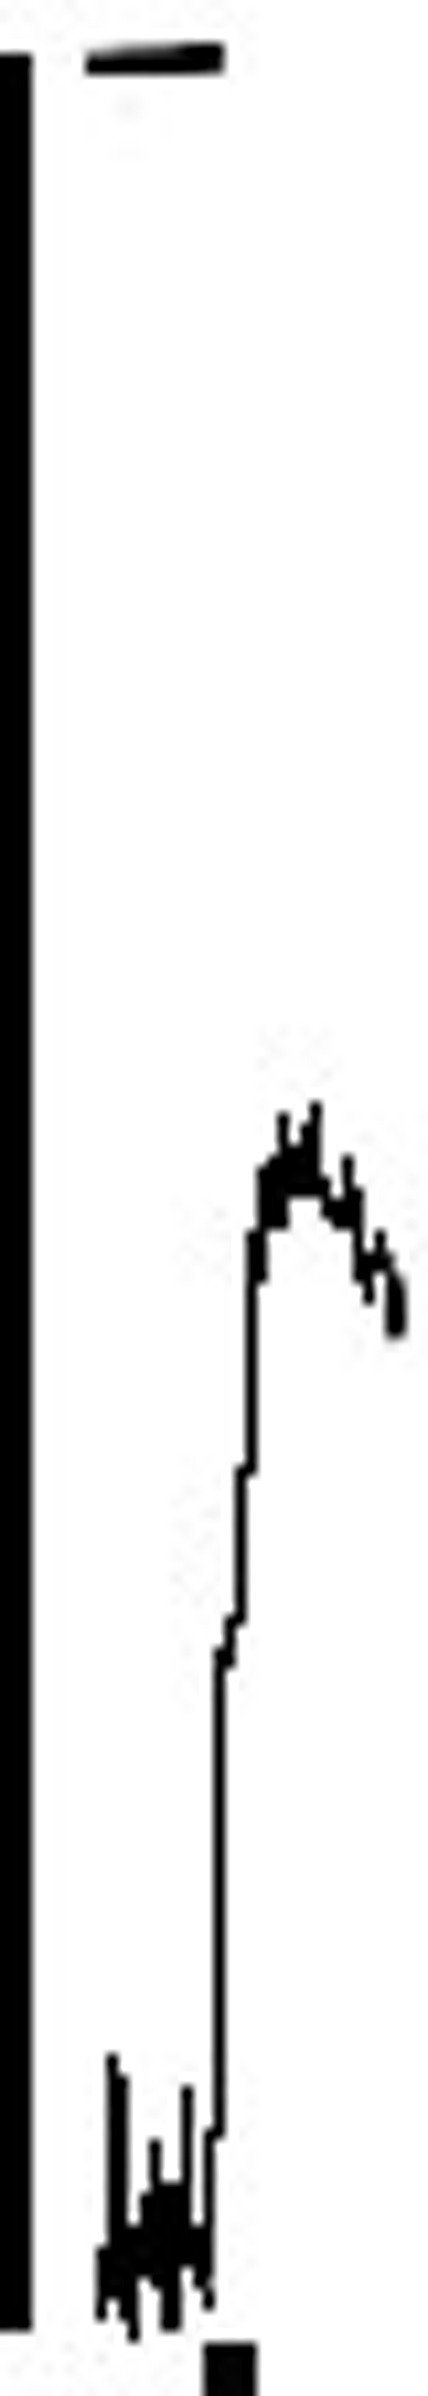
Contraction, in response to 200 μg/ml RC extract (added at the square symbol), on the guinea pig urinary bladder detrusor strip. Calibrations, vertical: 50% of the maximal spasm in response to 100 mM KCl, horizontal: 1 min.